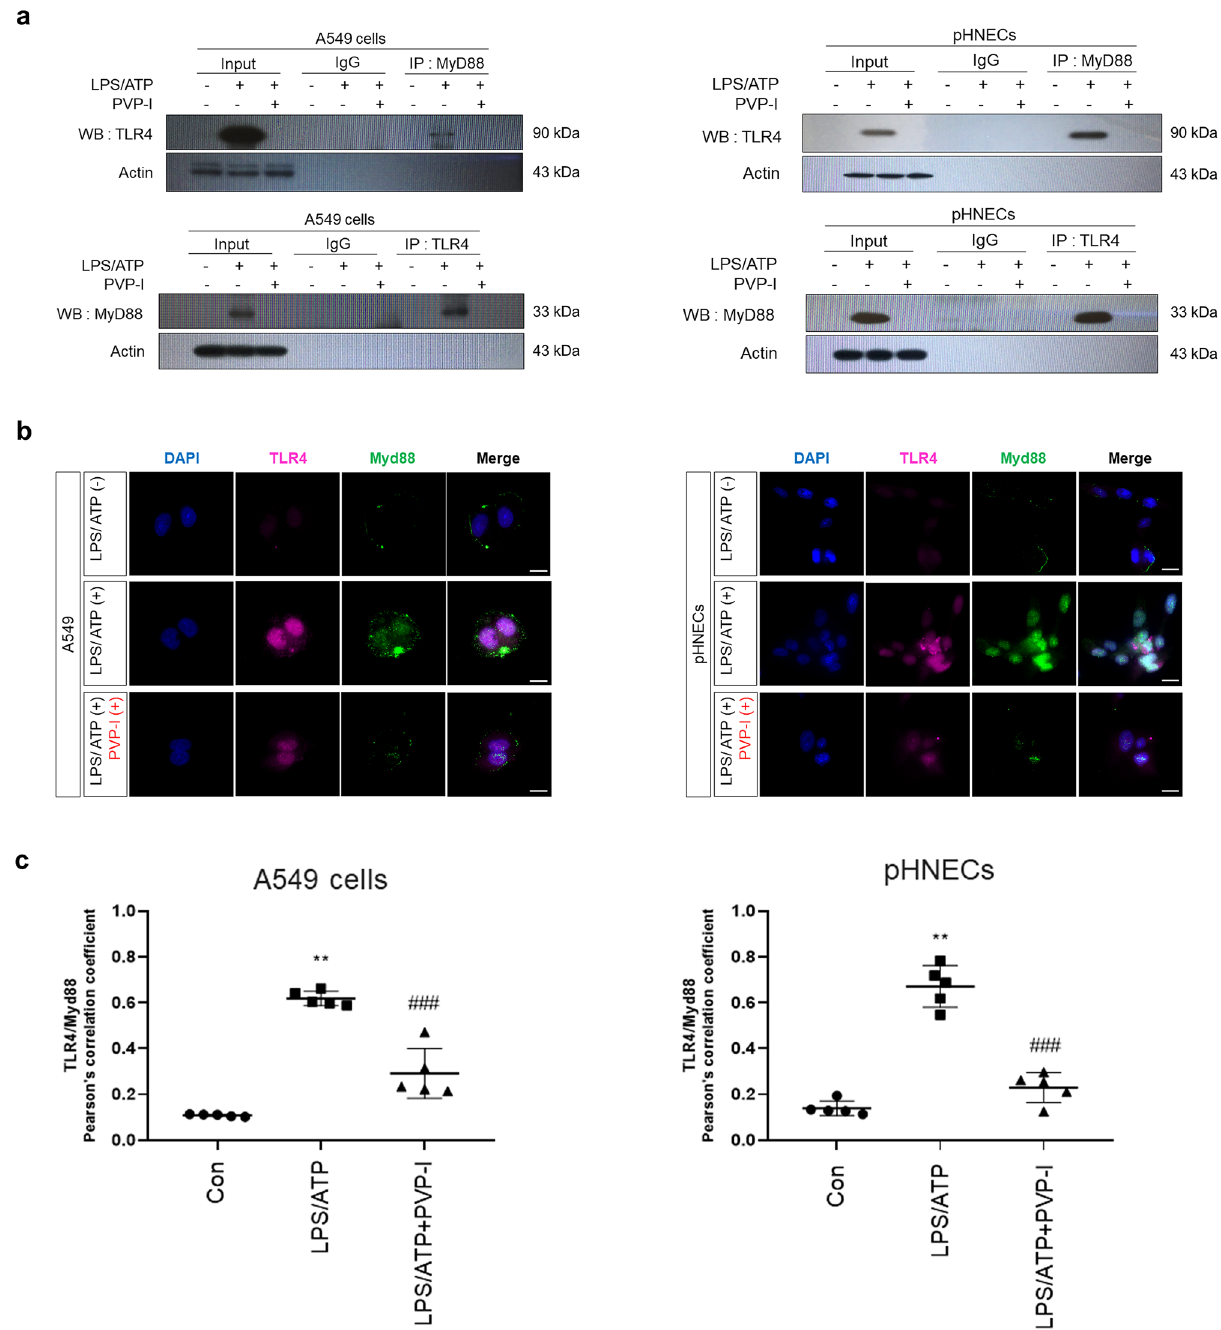
Figure 5. PVP-I inhibits TLR4 and MyD88 co-localization which were induced by inflammatory response. Airway epithelial cells were pre-treated with LPS (1000 ng/mL) and ATP (5 mM) and then exposed to 0.1% PVP-I. ( a ) The cells lysate were immunoprecipitated with anti- MyD88 and TLR4 antibody, and then immunoprecipitated proteins were detected using anti-TLR4 and anti-MyD88 antibodies. The pHNECs had the same experimental methods as the airway epithelial cells. PVP-I was found to inhibit the co-localization with TLR4 and MyD88 complex formation. Actin was used as a control for input. Airway epithelial cells were pre- treated with LPS and ATP for 60 min and then treated or not with PVP-I for 24 h. ( b ) Immunocytochemistry for TLR4 (red) and MyD88 (green) co-localization in A549 cells and pHNECs is shown. Increased expressions of TLR4 and MyD88 by LPS/ATP stimulation were inhibited by PVP-I treatment in A549 cells and pHNECs. The scale bar indicates 10 μm. Airway epithelial cells were pre-treated with LPS and ATP for 10 min and then treated or not with PVP-I for 10 min. ( c ) TLR4 and Myd88 colocalization was assessed by calculating the Pearson correlation coefficient on twenty images per condition using the JACoP plugin on